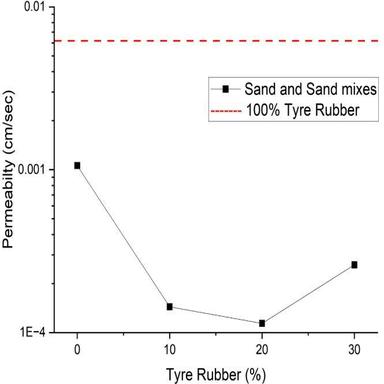
Influence of tyre rubber (in %) on coefficient of permeability. Fig. 12. Cohesion and angle of internal friction vs tyre rubber (in %).